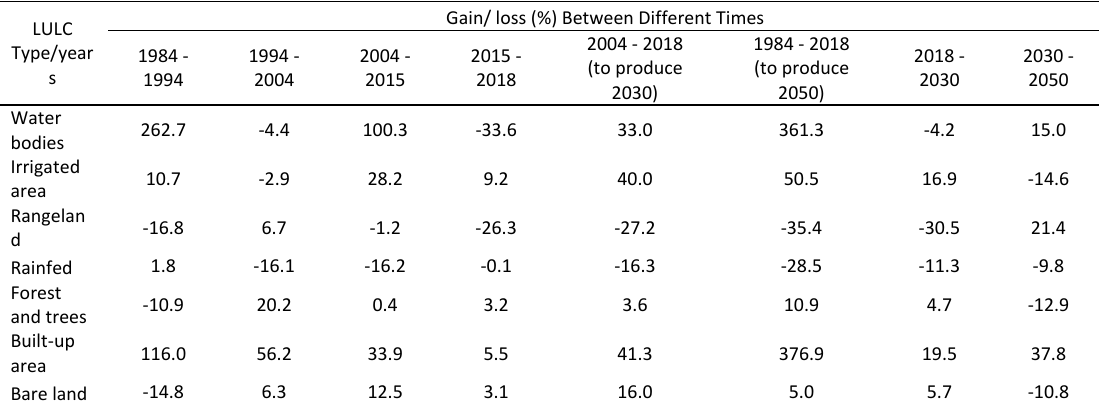
Table 8: The percentage of gain/loss of area for LULC (1984 to 2050)